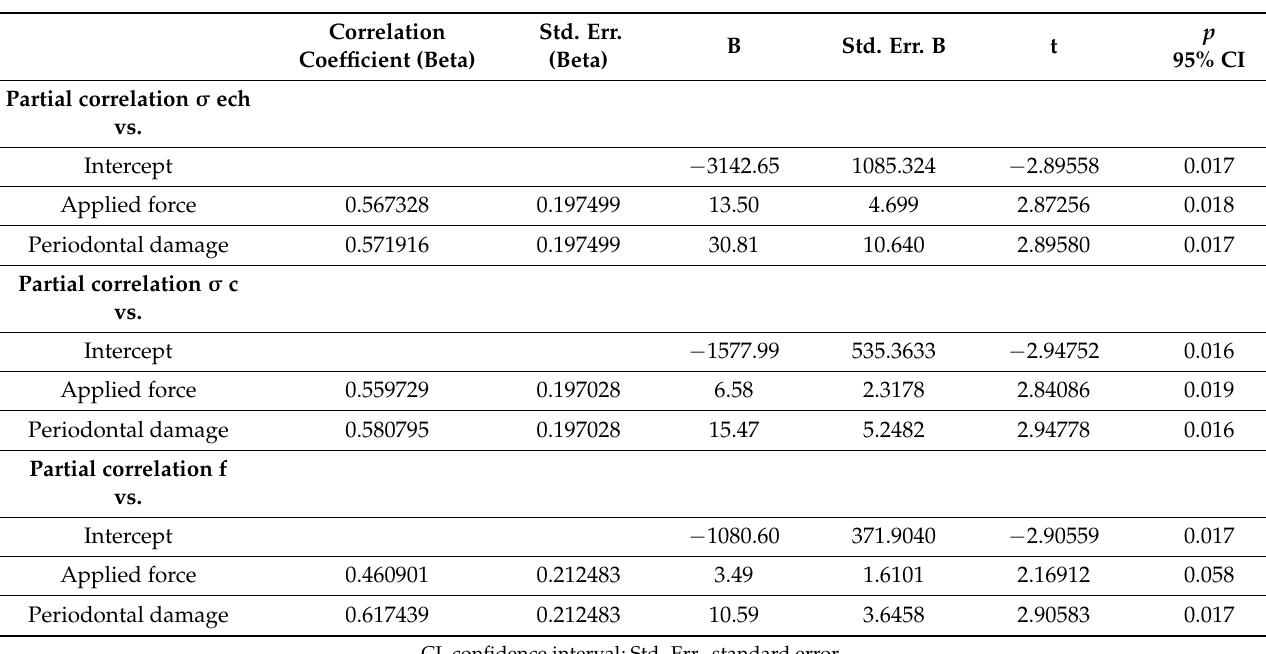
Table 6. Results of the multivariate analysis—partial correlation coefficient σ ech, σ c, and f.